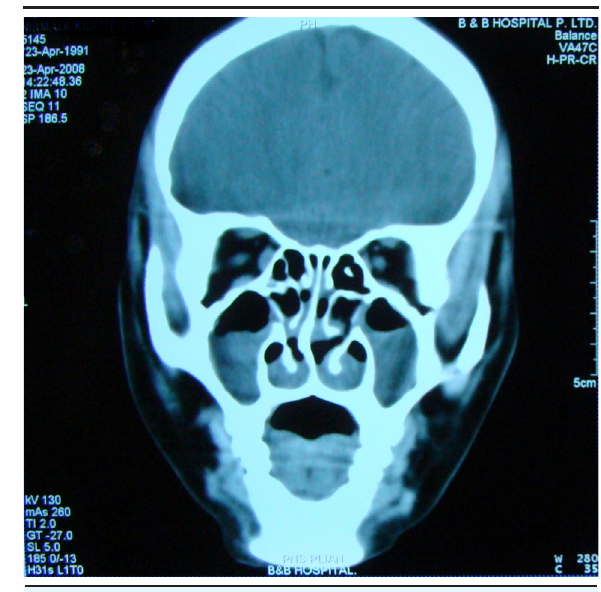
figure 3. ct scan of the paranasal sinuses showing diffuse hypodense mucosal thickening Ultrasonography of the abdomen showed the reversal of positions of the viscera, visibly spleen, stomach, splenic flexure of colon and sigmoid colon over